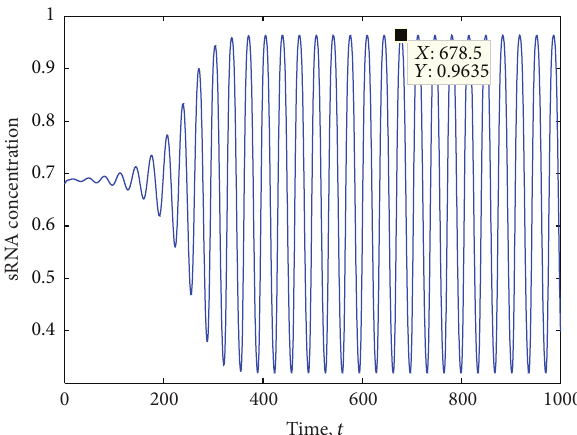
Figure 2: Time history diagram of small RNA concentration when 𝐷 = 0 .